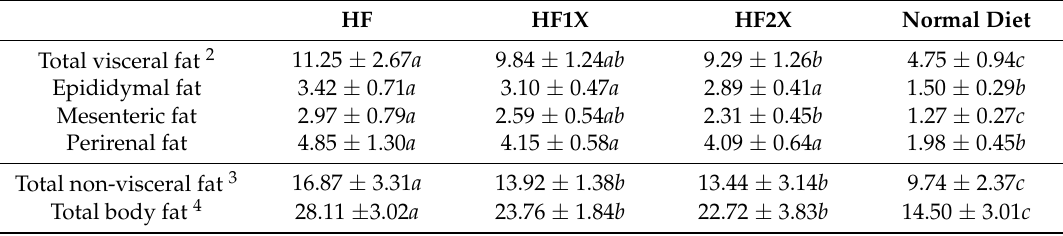
Table 2. Relative size of visceral fat pads and total body fat (g/100 g bw 1